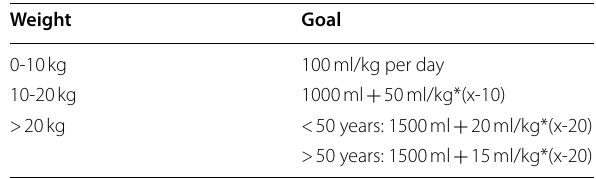
Table 2 Energy requirements (kcal/kg per day) for parenteral nutrition in different phases of disease